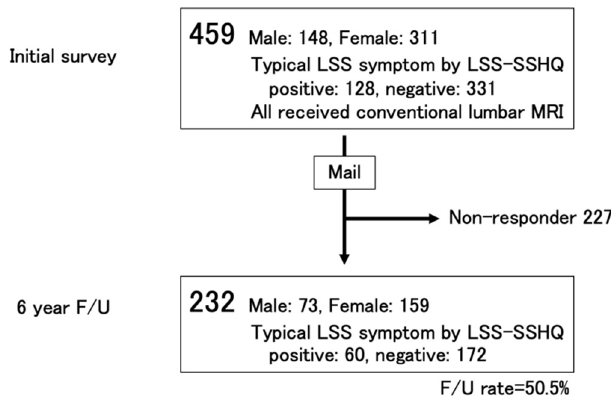
Figure 1. Figure 1. Participants.